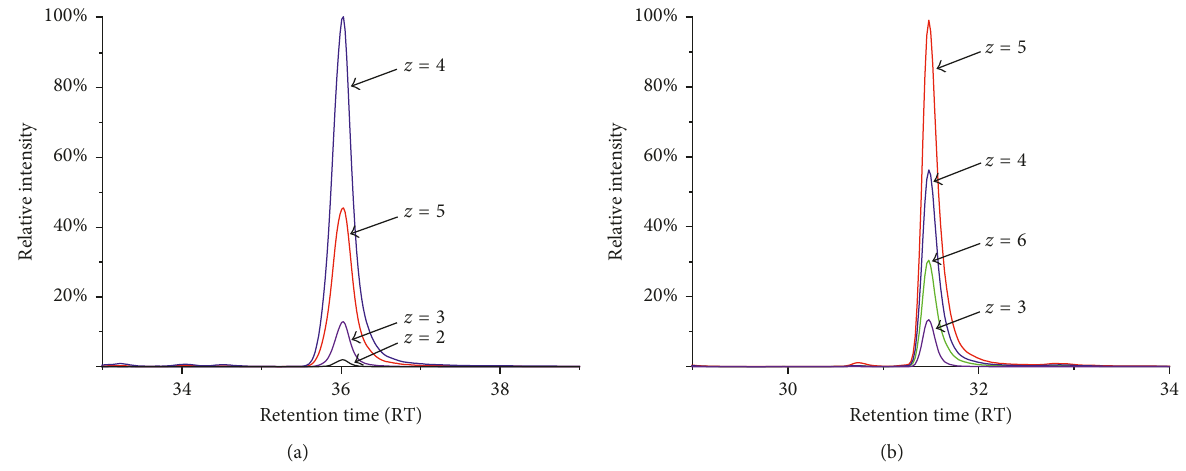
Figure 2: Extracted ion chromatograms of hepcidin-I and hepcidin-M according to charge state. (a) A hepcidin-I. (b) A hepcidin-M. Table 1: Relative ionization value of hepcidin-M to hepcidin-I according to charge state. Charge